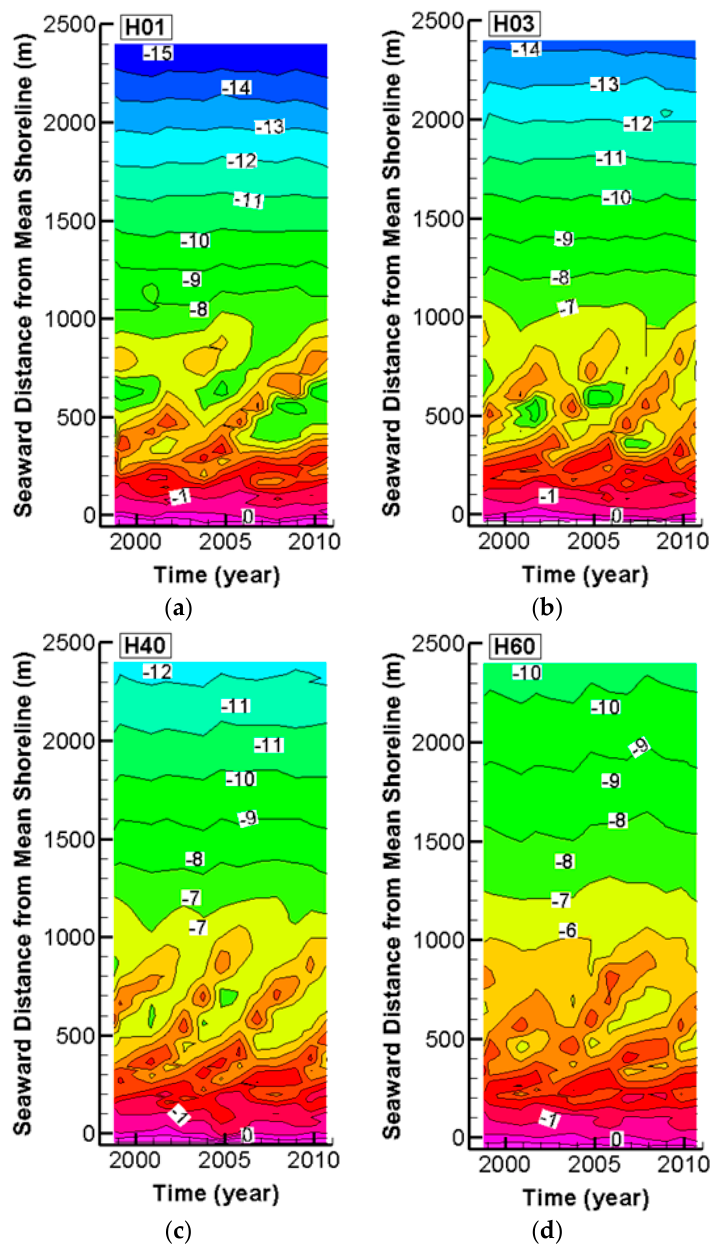
Figure 9. Variation of seabed level.